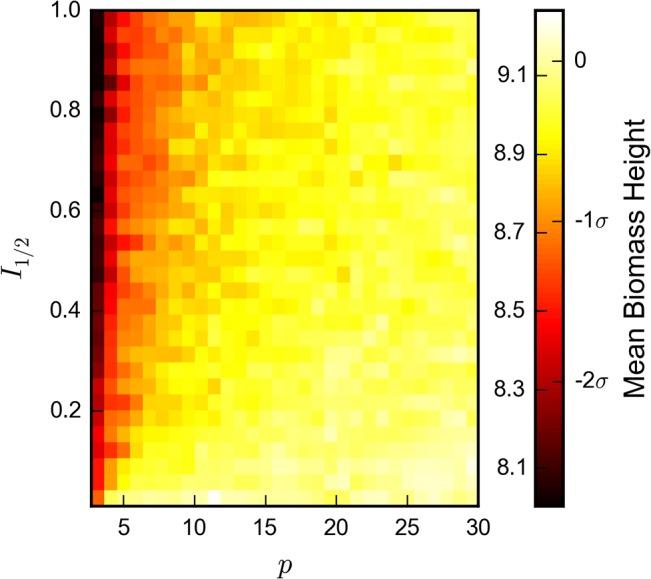
Effects of light-dependence parameters on depth of cell growth.Model biofilms that are light-limited (low p and high I
1/2) show decreased average biofilm cell depth. The scale for cell depth is shown with absolute values and in relation to the mean and standard deviation of a population of 102 light-independent samples taken with all other parameters held equal. A total of 96,000 samples were taken with fixed values α = 2, β = 1, b = 7, r = 1/ 2, and n
1/2 = 0.25 Each sample was grown to the same total mass of 2 × 103 cells.